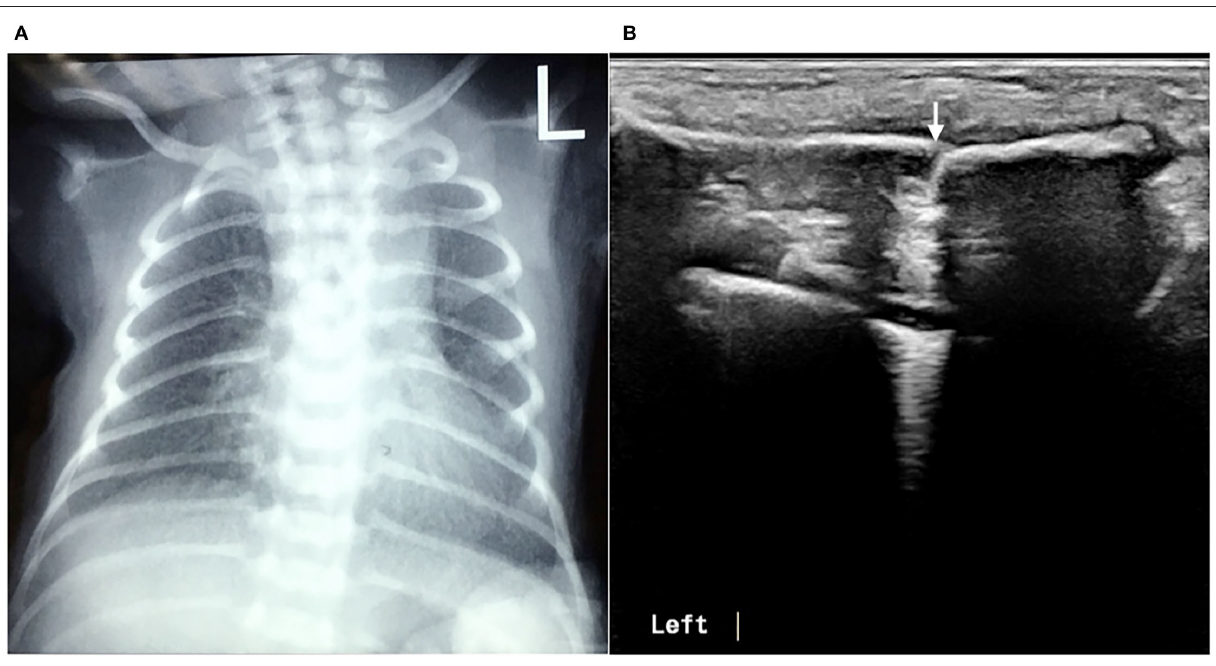
FIGURE 8 | Missed clavicle fracture on X-ray. The infant underwent a chest X-ray due to postnatal dyspnea, but there were no signs of fractures in either clavicle (A) . Physical examination found a bone rubbing sensation on the left clavicle on admission, and the subsequent ultrasound examination confirmed the presence of a fracture of the left clavicle (B)